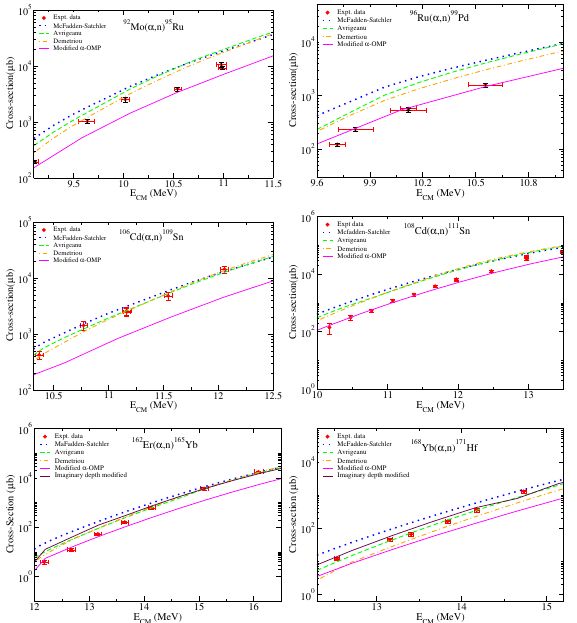
Figure 1. Expt. ( α ,n) reaction data [5–10] compared with the HF calculations using di ff erent α